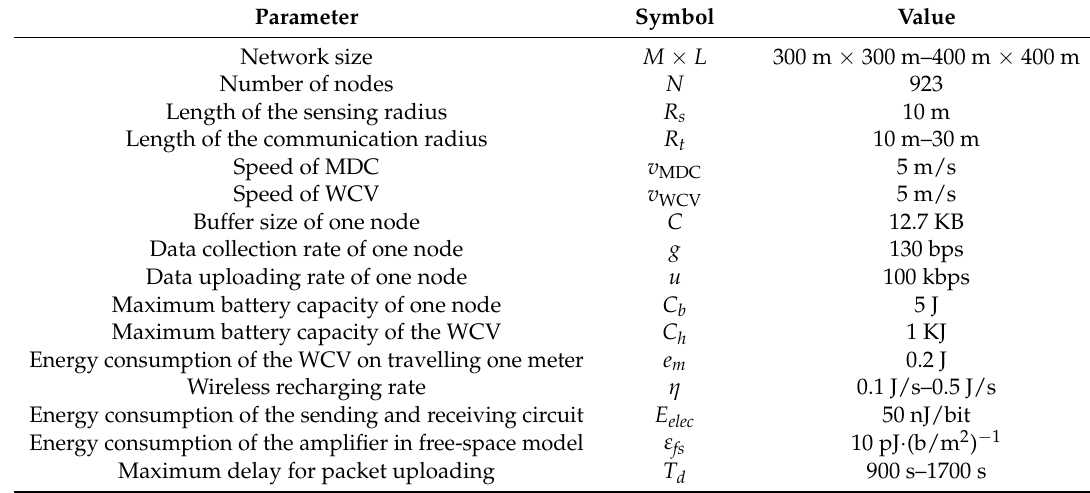
Table 4. Parameter values.